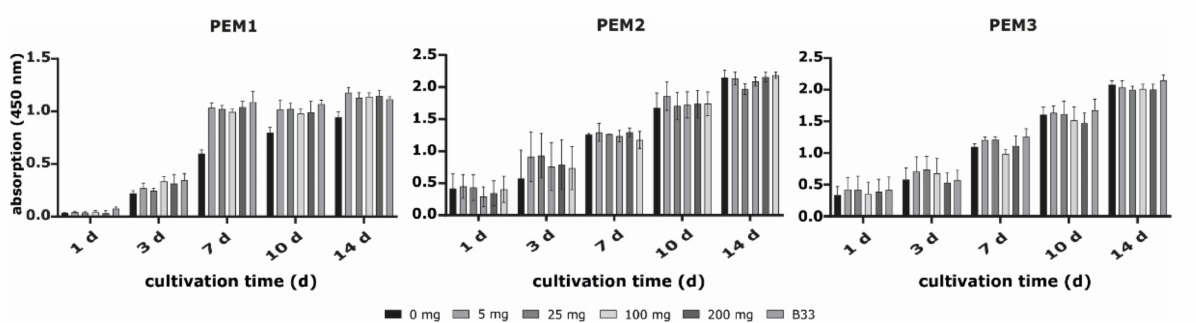
Figure 8. XTT assay for MC3T3 cells cultivated on different PEM films cross-linked with different EDC